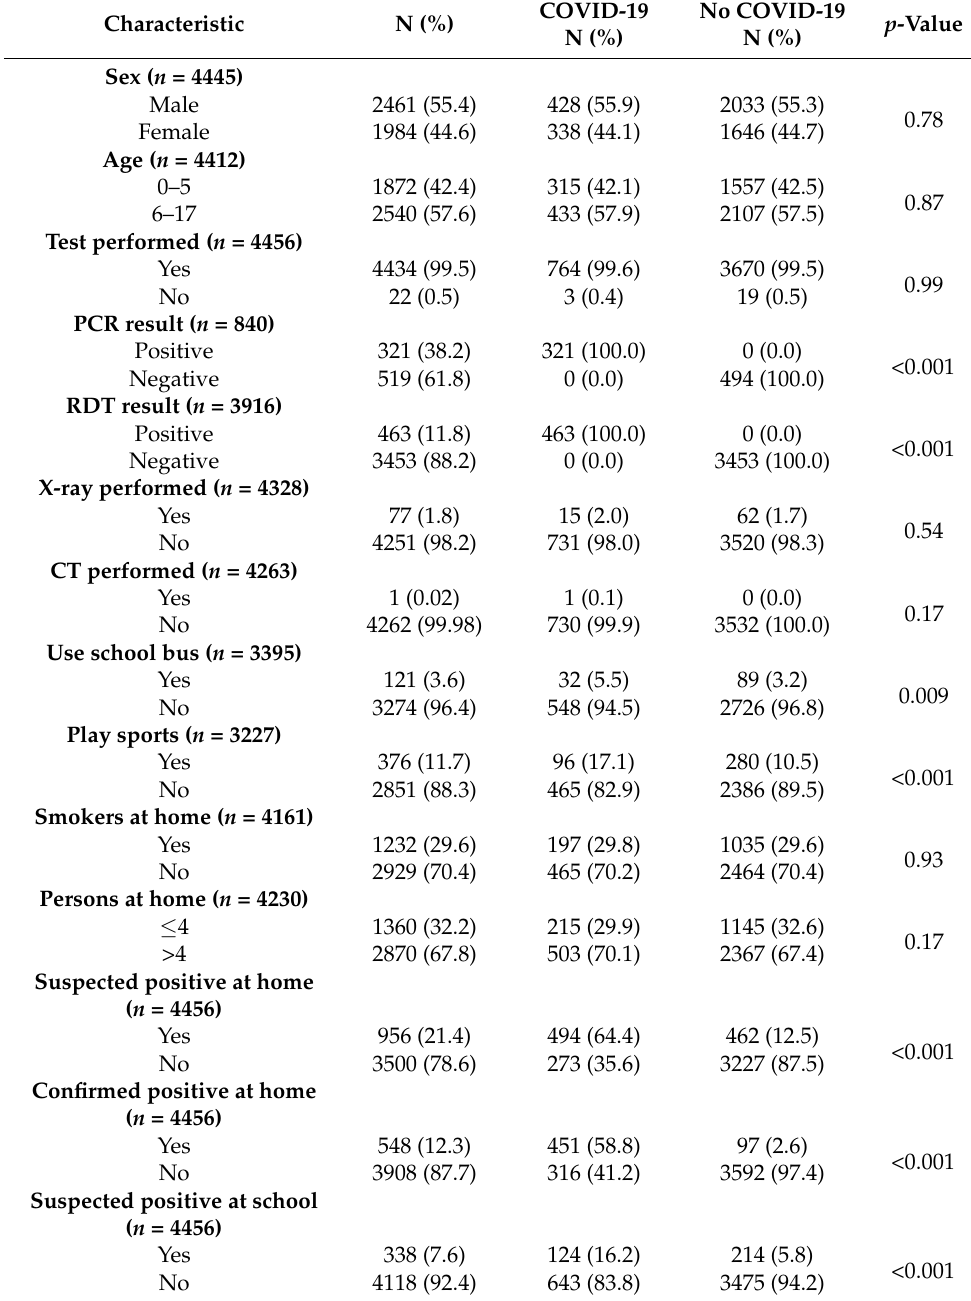
Table 1. Baseline epidemiological and diagnostic characteristics of the cases included in the dataset.